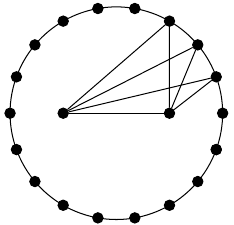
Figure 3.1: The graph H with a (2, 3) -regular